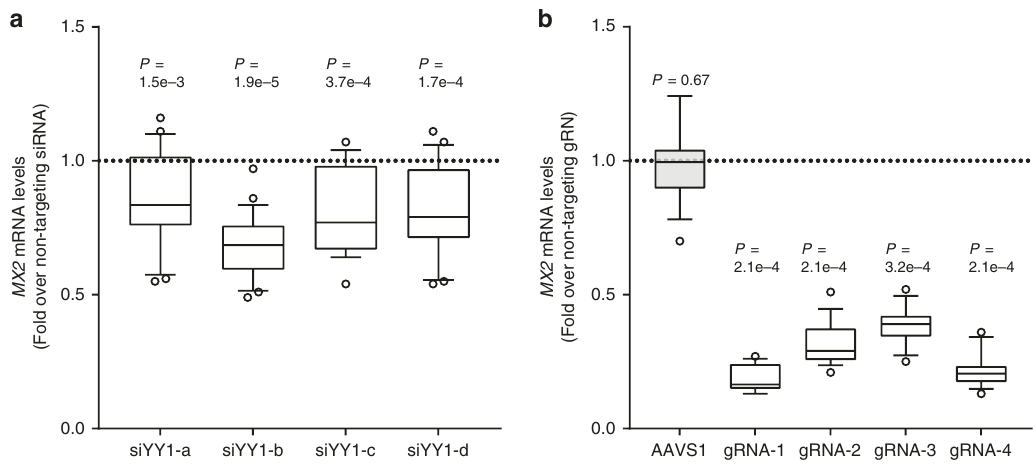
Fig. 5 YY1 and rs398206 affect MX2 expression in melanoma cells. a YY1 was knocked down using four different siRNAs in UACC647 cells, and MX2 levels were measured. GAPDH -normalized MX2 mRNA levels are shown as fold change over those from non-targeting siRNA. Four biological replicates of n = 6 were combined (total n = 24). b CRISPRi using dCAS9-KRAB-MeCP2 and four different gRNAs targeting rs398206 in UACC903 cells. MX2 mRNA levels ( GAPDH -normalized) are shown as fold change over those from non-targeting gRNA. Three biological replicates of n = 6 were combined (total n = 18, except gRNA-3, n = 17). gRNA 1, 3, and 4 directly overlap rs398206. gRNA 2 targets ~25 bp upstream of rs398206. AAVS1 (gRNA targeting adeno- associated virus integration site on Chr19). Box: Median and 25th to 75th percentile. Whisker: 10th to 90th percentile. P -values are shown from one- sample Wilcoxon test (two-sided) for difference from non-targeting siRNA/gRNA. Dotted line denotes the MX2 levels in non-targeting siRNA/gRNA control. Source data are provided as a Source Data fi